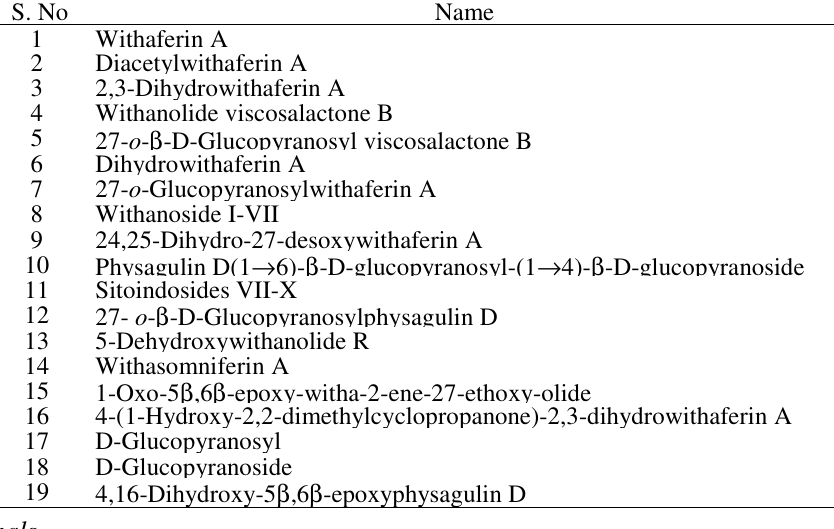
Table 1. Active compounds of Withania somnifera 16 S.